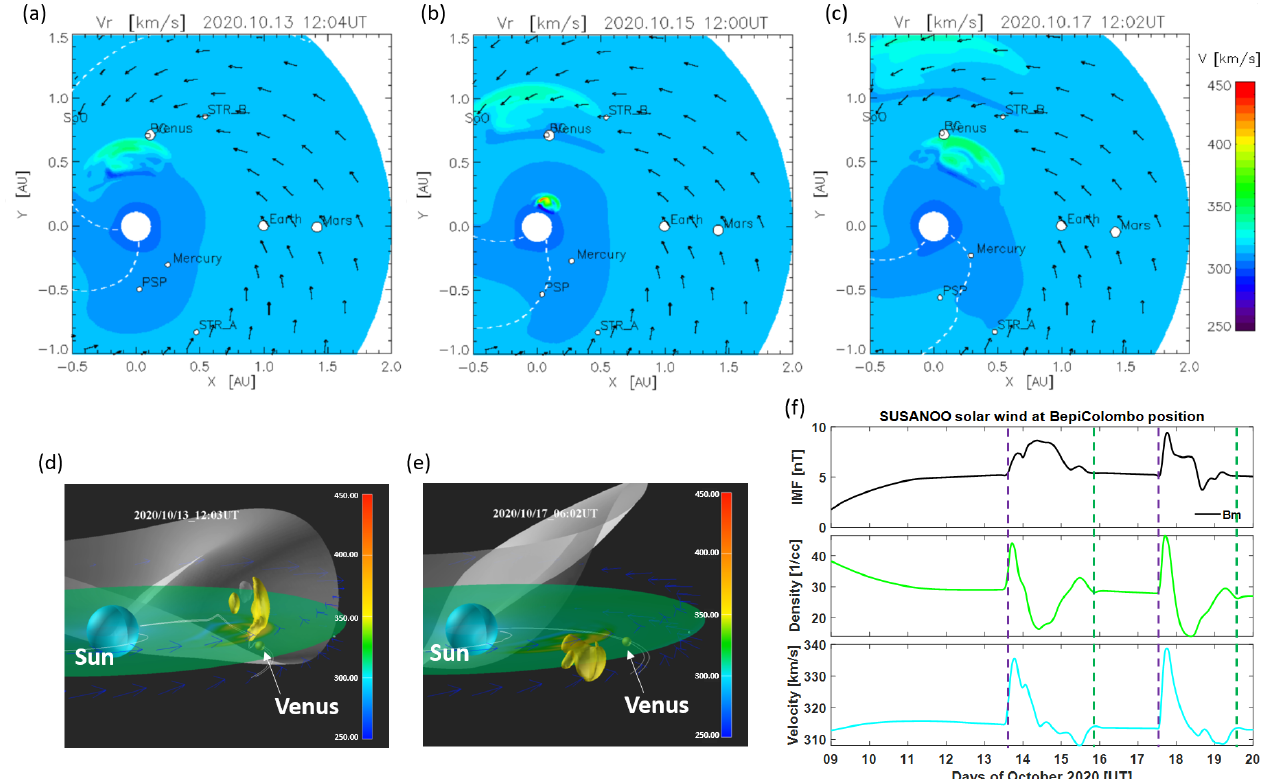
Figure 12. Stills from the SUSANOO simulation performed for the period 9–18 October 2020. (a–c) 2D plots of the solar wind velocity at the ecliptic plane on 13 October 2020 at 12:04UT (CME arrival at BepiColombo), 15 October 2020 at 12:00UT (trailing edge of the CME leaves BepiColombo), and 17 October 2020 at 12:02UT (a second CME arrival at BepiColombo). The Sun is the white largest circle, and the different planets and satellites are also labelled and the black arrows show the direction of the solar wind flow. The yellowish blobs toward Venus represent the CMEs of this study. The background colours represent the speed, as indicated in the colour scale. (d–e) Same as before but in 3D. The green plane is the ecliptic and the white-transparent surface is the heliospheric current sheet. The yellowish blobs toward Venus are the CMEs of this study. The colour bar velocity is only applicable to the CME. (f) Time series of IMF (magnitude in black), density (in green), and velocity (in light blue) at the BepiColombo location obtained from the simulation. The vertical dashed purple and green lines indicate the arrival and end time of the CMEs at